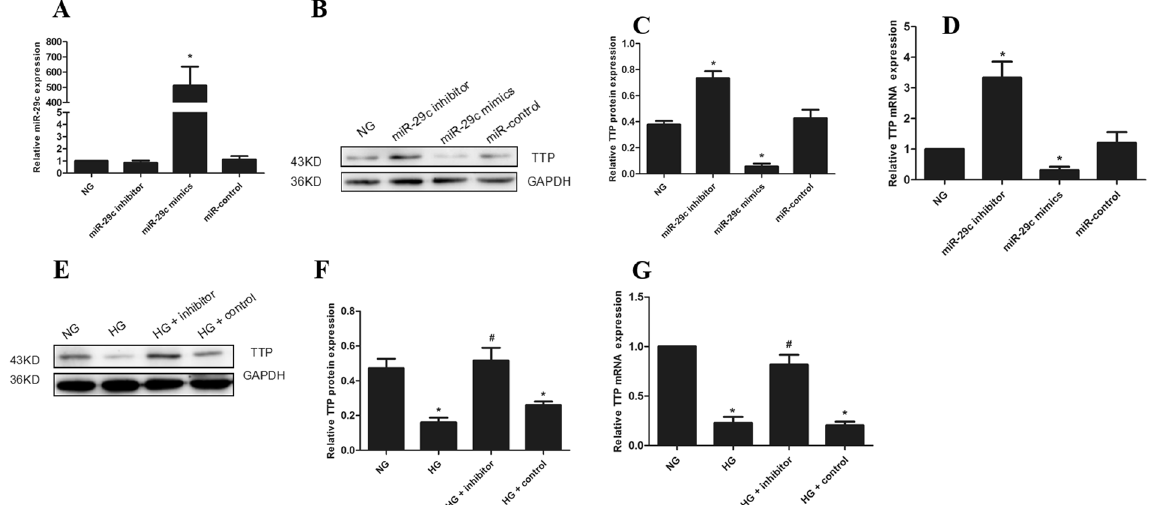
Figure 6. miRNA-29c targets TTP. ( A ) The expression of miRNA-29c in podocytes transfected with mimics (30 nM) or inhibitors (100 nM) for 6 h. ( B ) Western blot analysis showed the expression of TTP in podocytes transfected with mimics or inhibitors for 36 h. ( C ) The quantified Western blot data shown in graph format. ( D ) qRT-PCR analysis of TTP mRNA expression in podocytes transfected with mimics or inhibitors. ( E ) Podocytes were transfected with miRNA-29c inhibitor (100 nM) and treated with HG (25 mM) for 36 h as compared with NG. ( F ) The quantified Western blot data shown in graph format. ( G ) qRT-PCR analysis of TTP mRNA expression in podocytes transfected with miRNA-29c inhibitors (100 nM) and treated with HG (25 mM) for 24 h. Results were obtained from three independent experiments. The data are shown as mean ± SEM. * P < 0.05 compared with control. # P < 0.05 compared with high